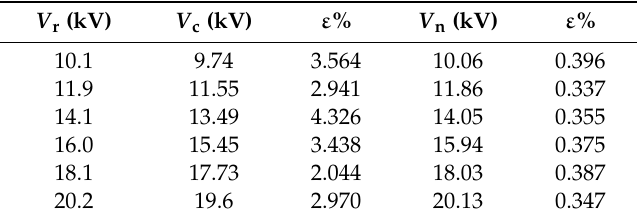
Table 5. Gauss–Chebyshev node parameter reconstruction method measurement results.